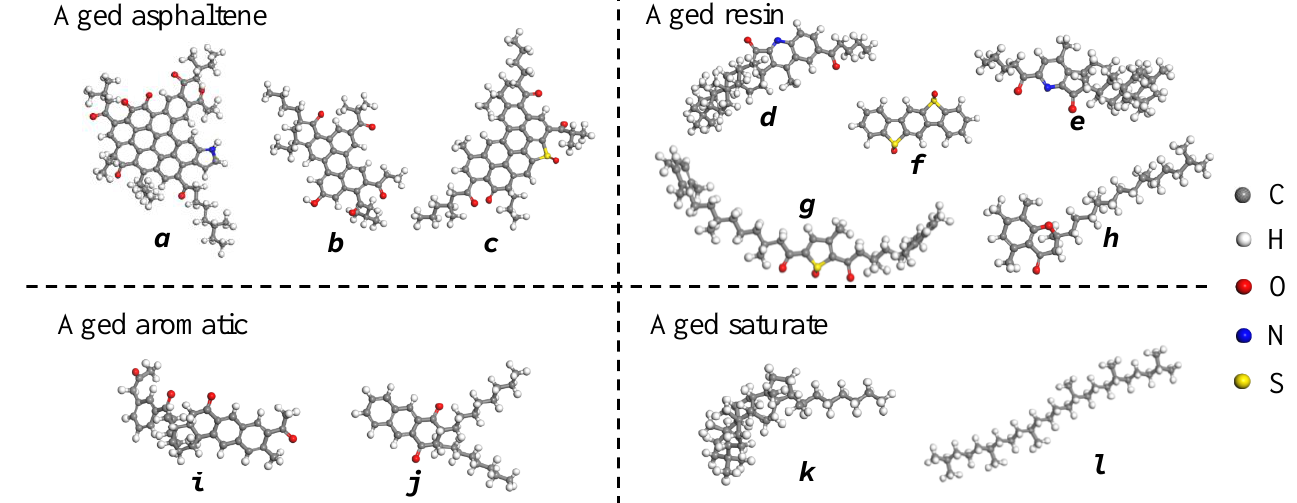
Figure 2. Representative molecules of the four components in aged asphalt binder: ( a – c ) aged asphaltene; ( d – h ) aged resin; ( i , j ) aged aromatic; ( k , l ) aged